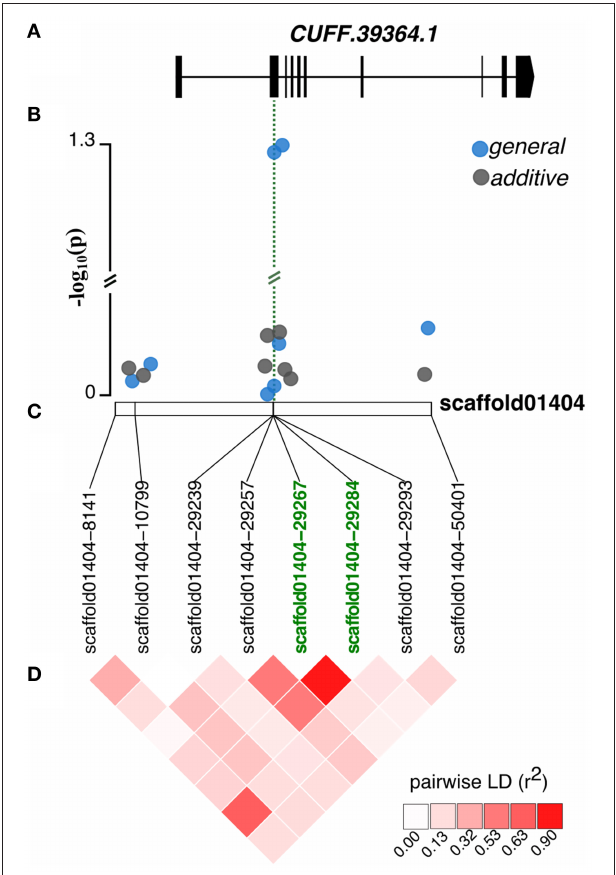
FIGURE 7 | SNP effect on fruit size. (A) Candidate gene encoding a chloroplast rhomboid-like protease ( CUFF.39364.1 ) where a missense variant was detected in the second exon. (B) Significance of SNPs detected by additive (gray dots) and general (blue dots) gene action models along the scaffold01404. The green dashed line indicates the genic region affected by the two significant SNPs. Double bars indicate out of scale. (C) Scaffold positions of the SNPs, highlighting the SNPs associated with the trait in green. (D) Pairwise linkage disequilibrium (correlation coefficient r 2 ) between markers along the